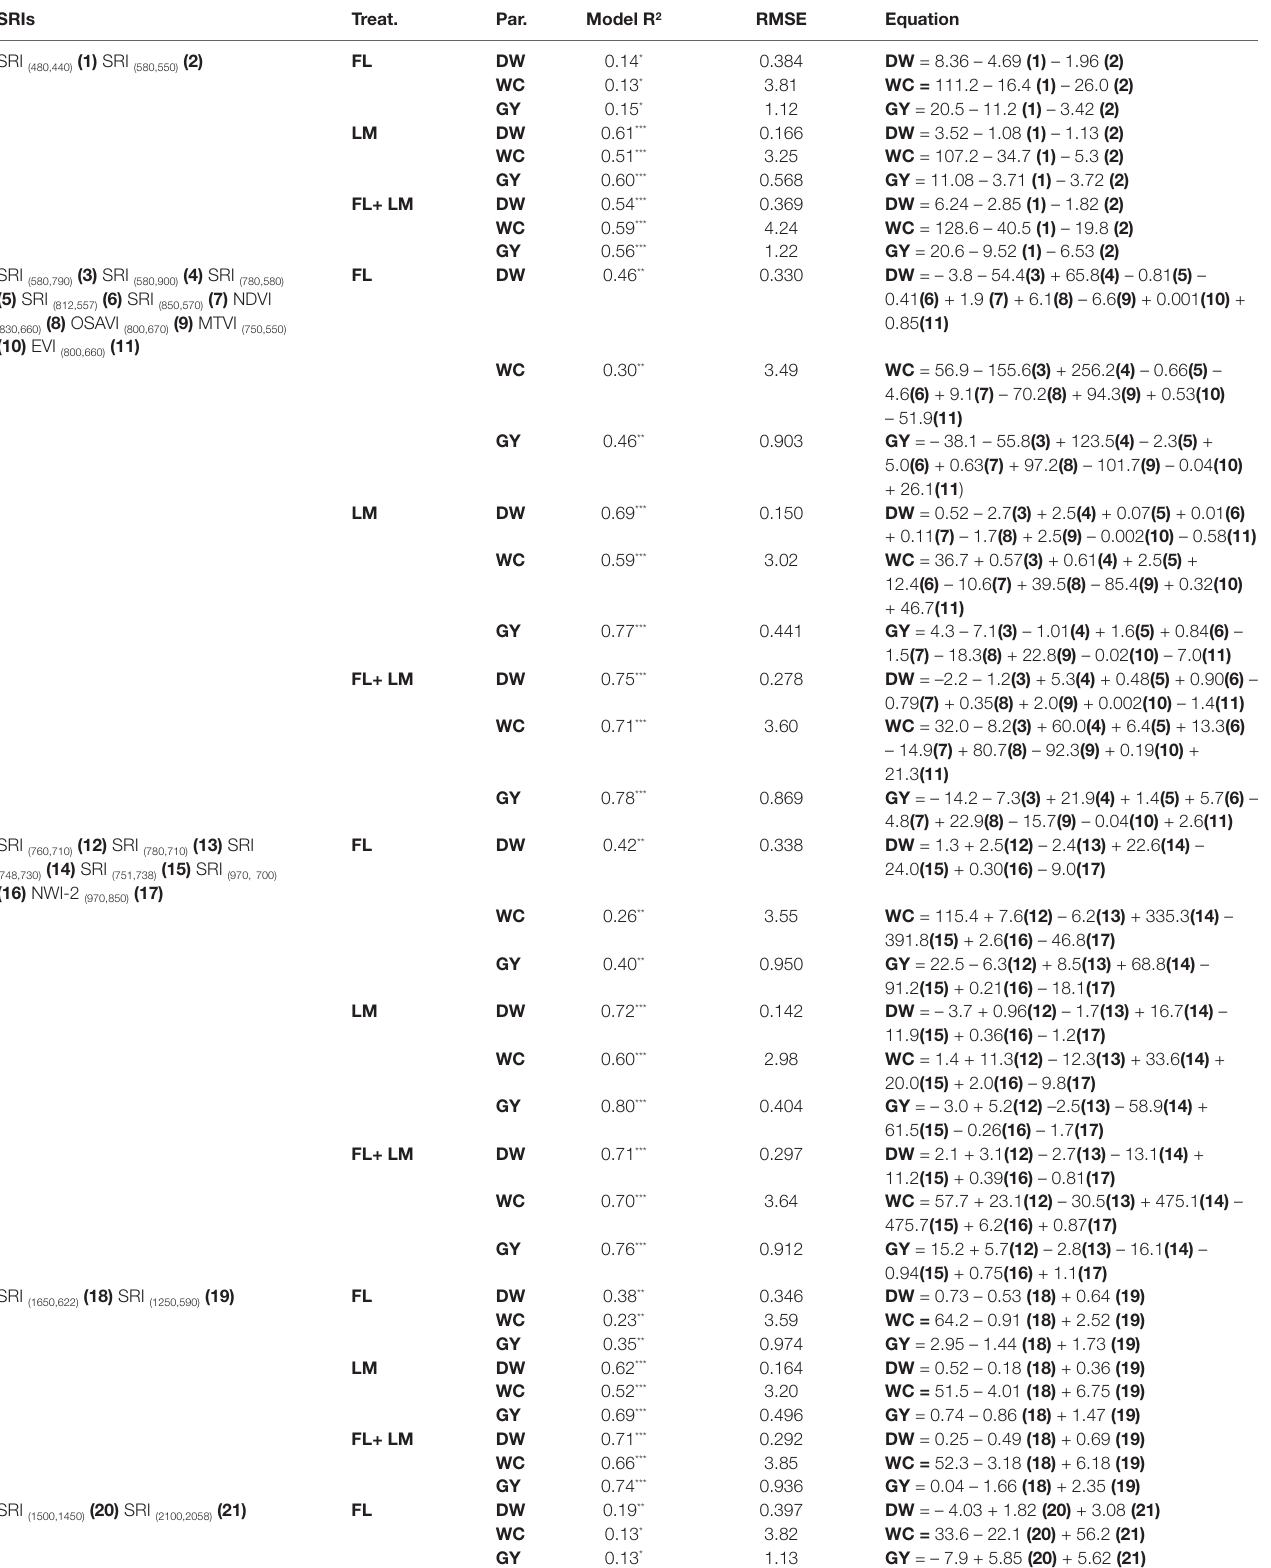
TABLe 4 | SMLR Model summary for estimating the measured parameters based on different groups of SRIs. SRIs